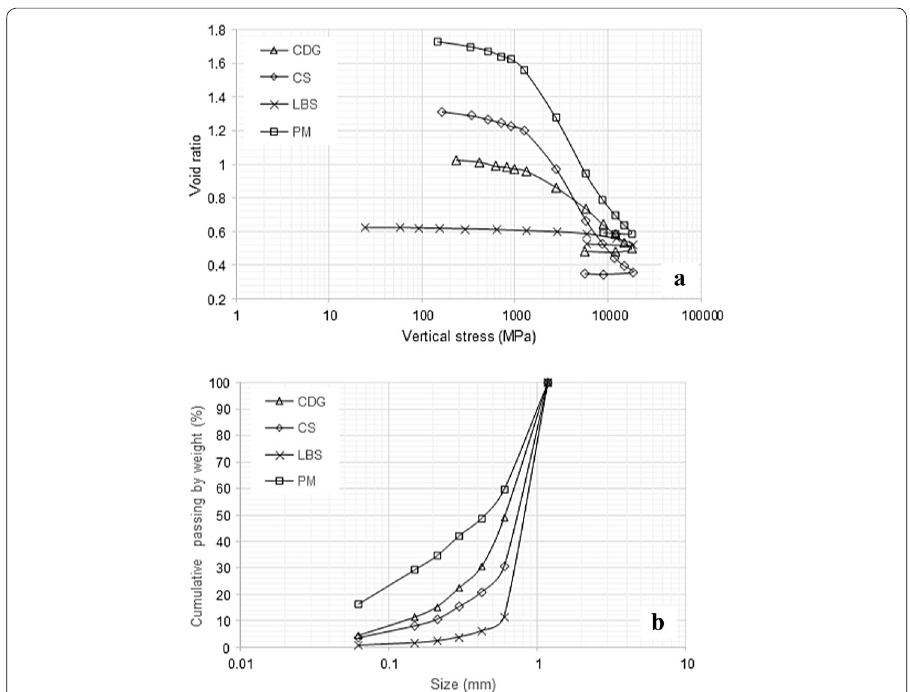
Fig. 7 Experimental results for one-dimensional compression tests of four sands: a the void ratio against logarithm effective vertical stress; b particle size distribution